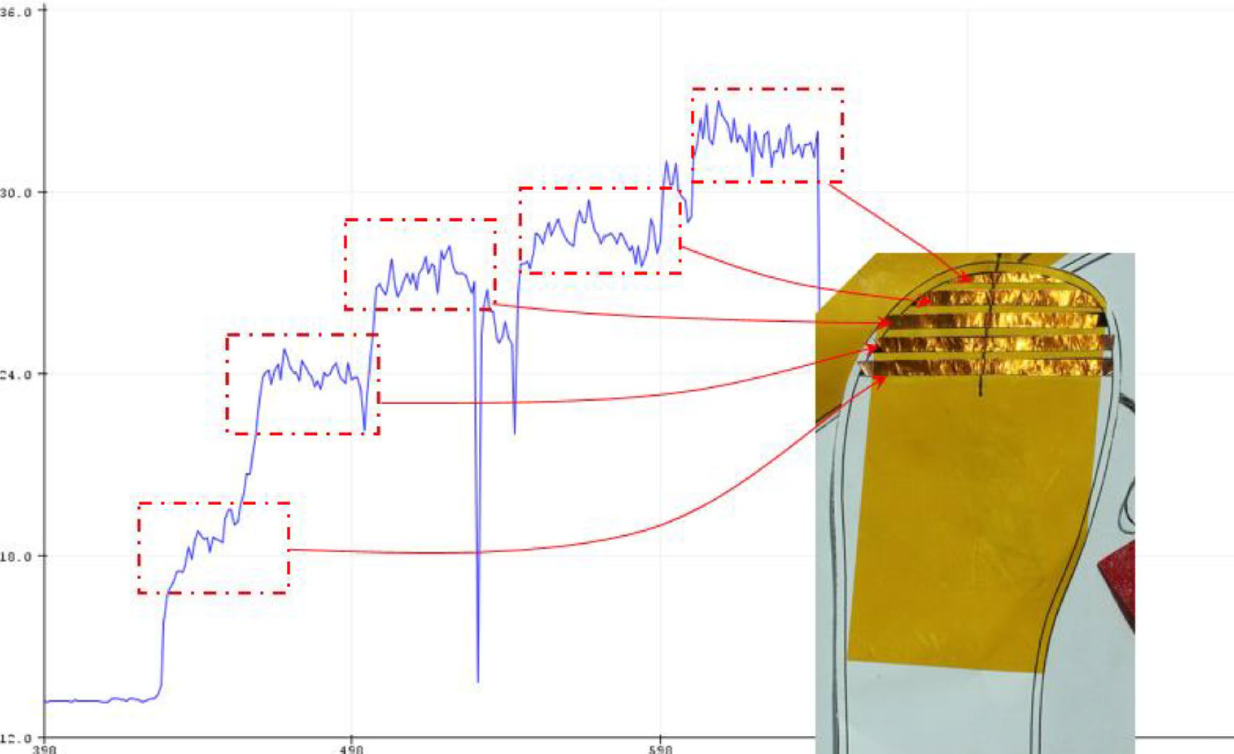
Figure 12. Incremental increase when lasts covered each copper stripe.